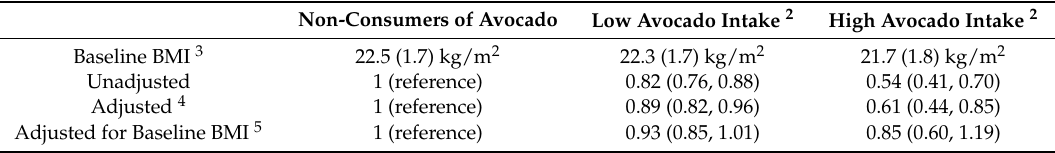
Table 4. Odds (95% CI) of becoming overweight/obese by level of avocado intake in Adventist Health Study-2 cohort 1